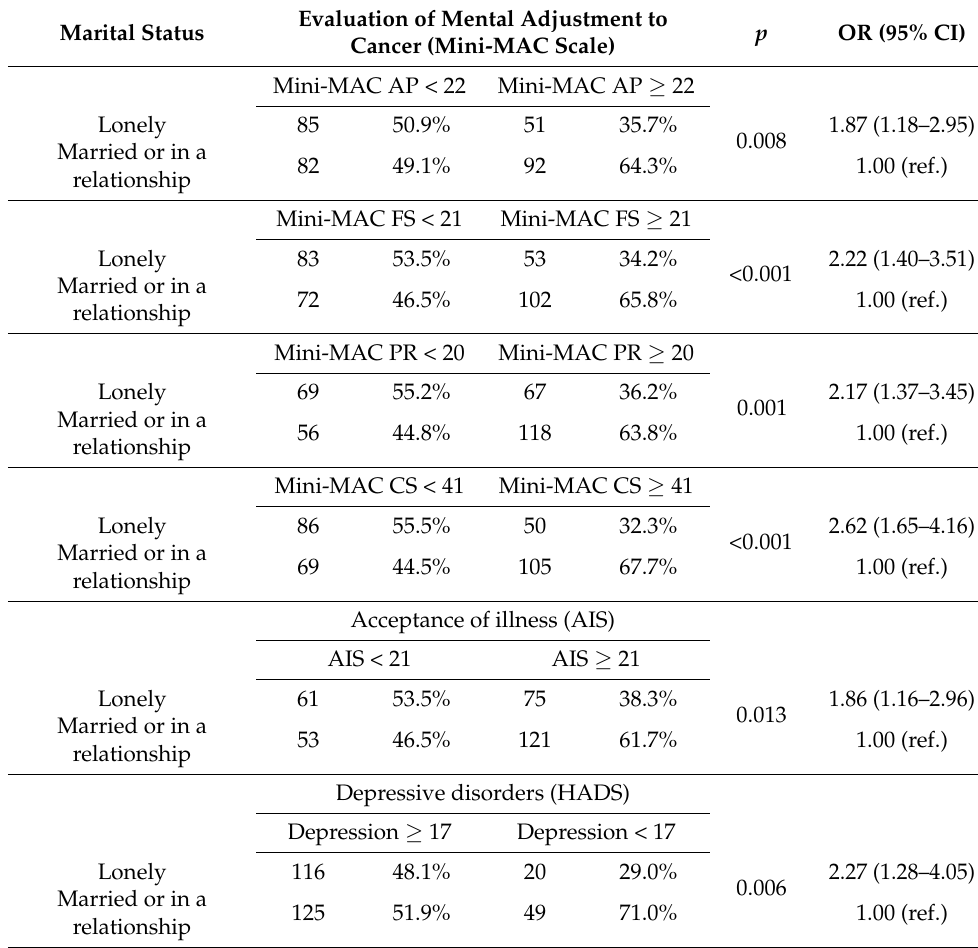
Table 3. Number (percentage) of patients in groups differing in marital status and the results of the questionnaires used, the results of independence tests and the values of odds ratios and their 95% confidence